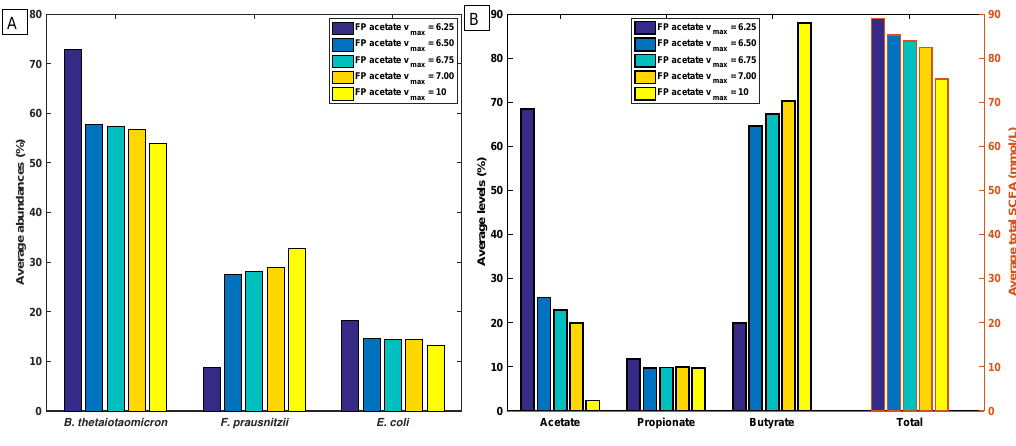
Figure 9. Effect of the F. prausnitzii maximum acetate uptake rate v max on ( A ) species abundances and ( B ) acetate, propionate and butyrate levels and the total SCFA